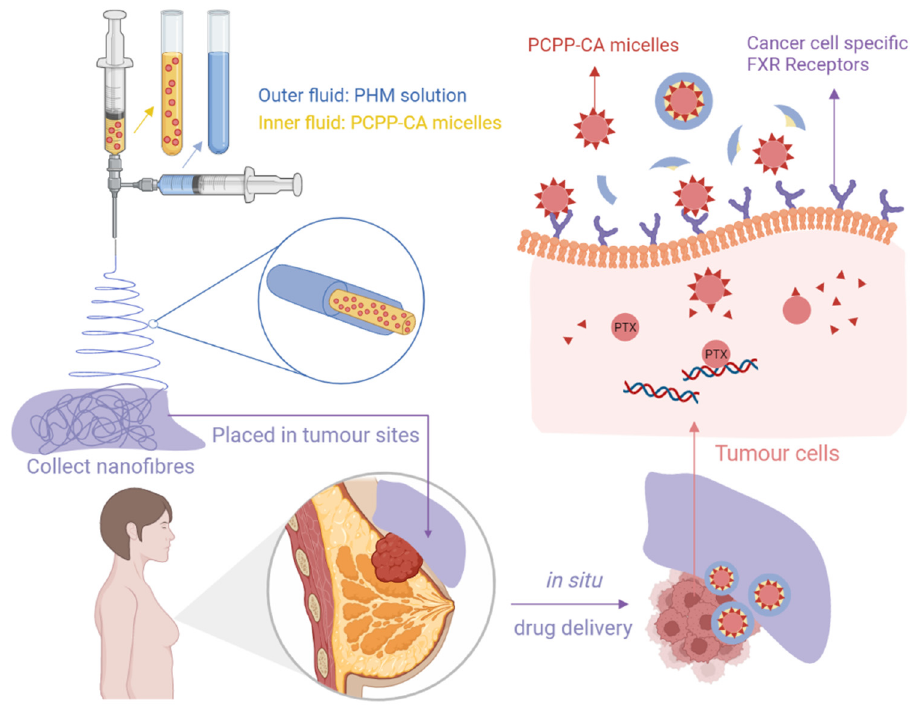
Figure 4. The transdermal nanofibre platform containing paclitaxel-loaded PCPP-CA micelles syn- thesised by coaxial electrospinning. Created with BioRender.com and adapted from [67].